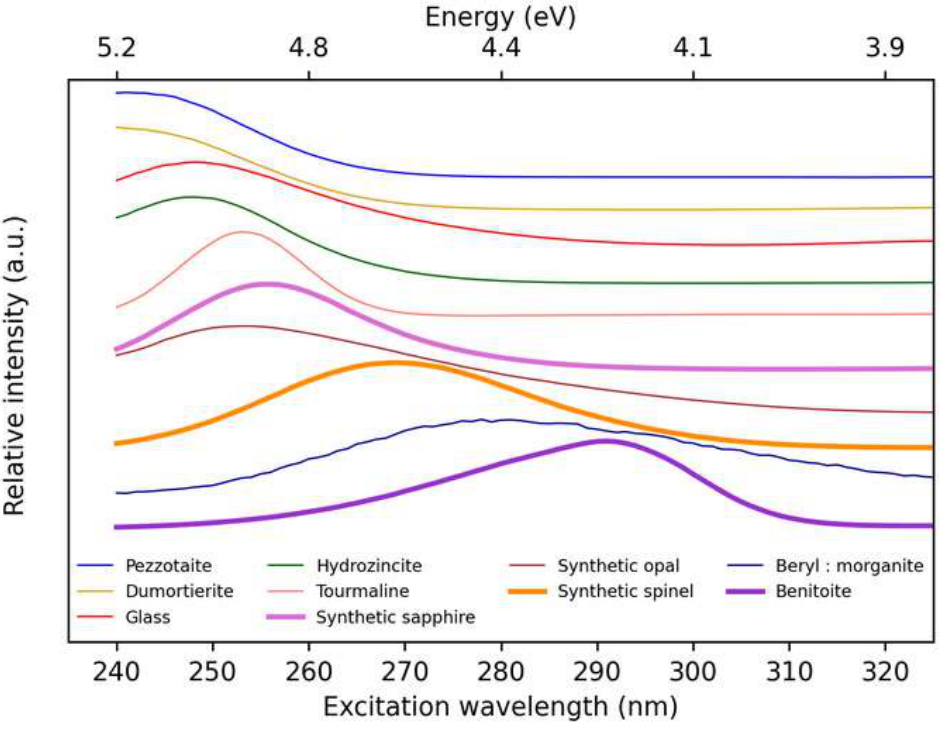
Figure 3. Excitation spectra of our ten samples for a luminescence excited by shortwave ultraviolet. Apparent maxima of the broad excitation band are located in the 240 to 290 nm range, as expected. Thicker lines mark reference materials. Spectra are shifted vertically for clarity.